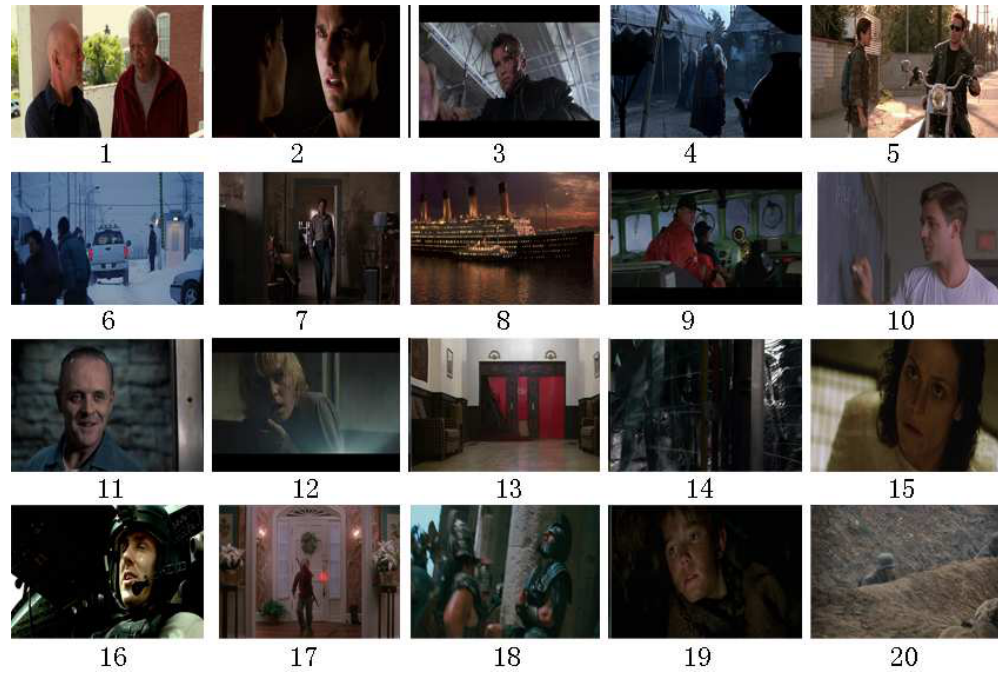
Figure 5. Key-frames from the testing